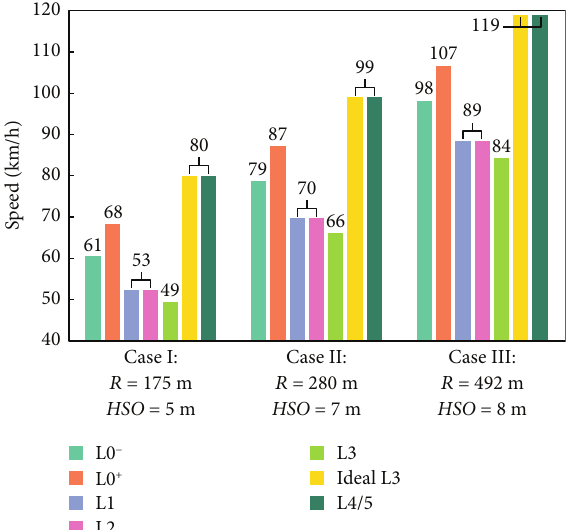
Figure 5: Comparison of maximum allowable speeds for all scenarios under the condition of given horizontal sight line offsets and